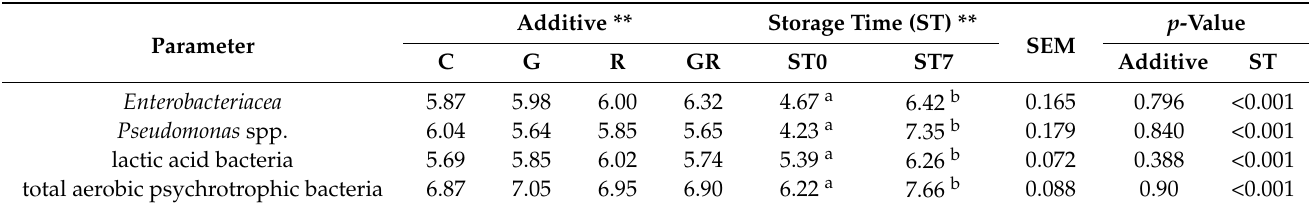
Table 4. Microbiological quality (log 10 CFU/g) of raw burgers (means ±